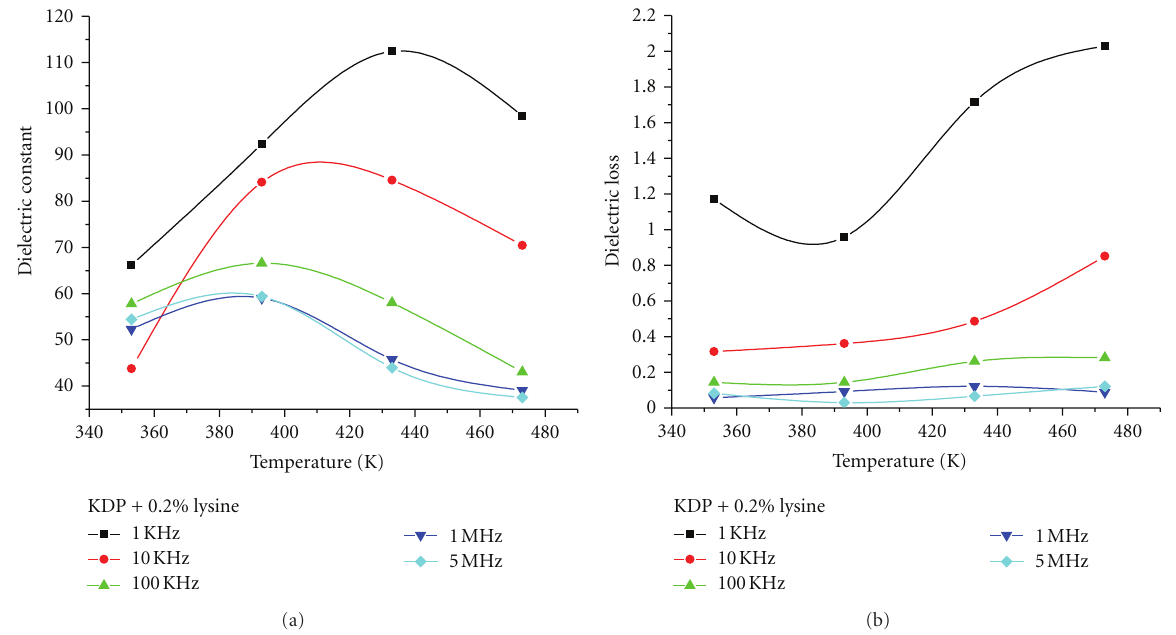
Figure 5: (a) variation of dielectric constant with temperature for all frequencies (lysine-doped KDP). (b) variation of dielectric loss with temperature for all frequencies (lysine-doped